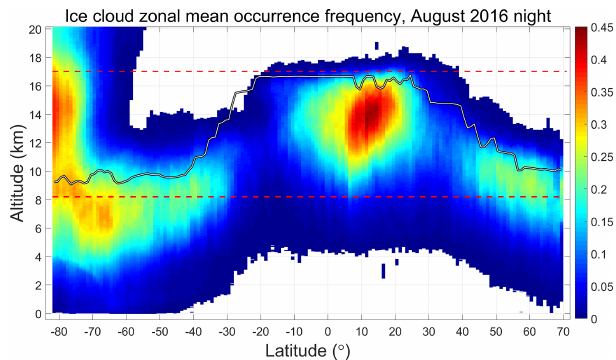
Figure 2. Zonal mean occurrence frequency of ice clouds for V4 nighttime data acquired during August 2016. The solid gray line shows the mean tropopause heights for the month, while the red dashed lines demarcate the V3 calibration cloud search region be- tween 17 and 8.2km. Polar stratospheric clouds are responsible for the high occurrence frequencies above the tropopause poleward of ∼ 60 ◦ S.